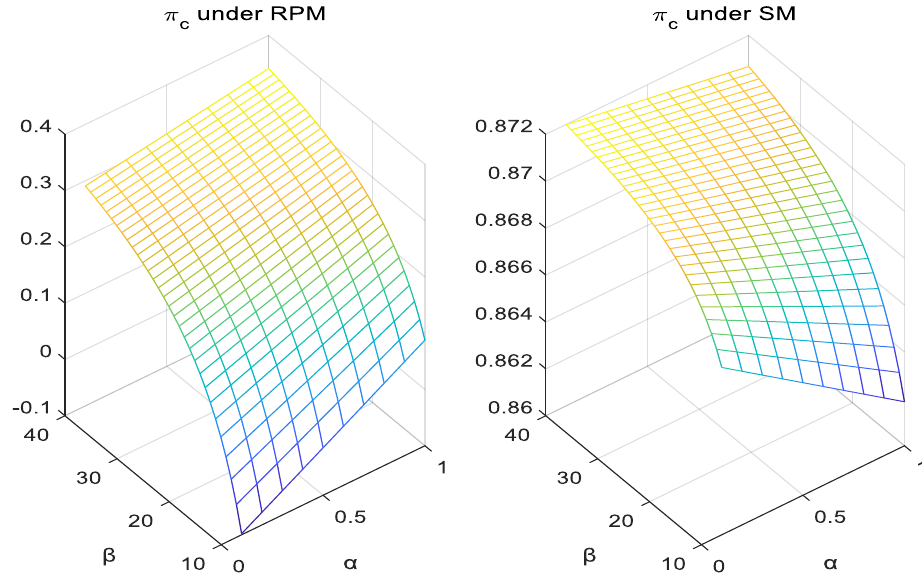
Figure 9. Collector’s profit vs. fixed cost coefficient and environmental benefit coefficient under RPM ( left ) and SM ( right ).